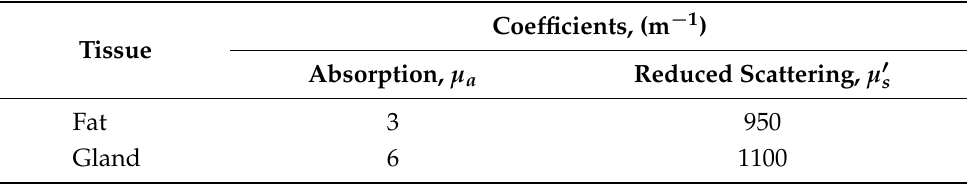
Table 1. The optical properties of the biological domains that were used in the simulations. The values were obtained from Ref.